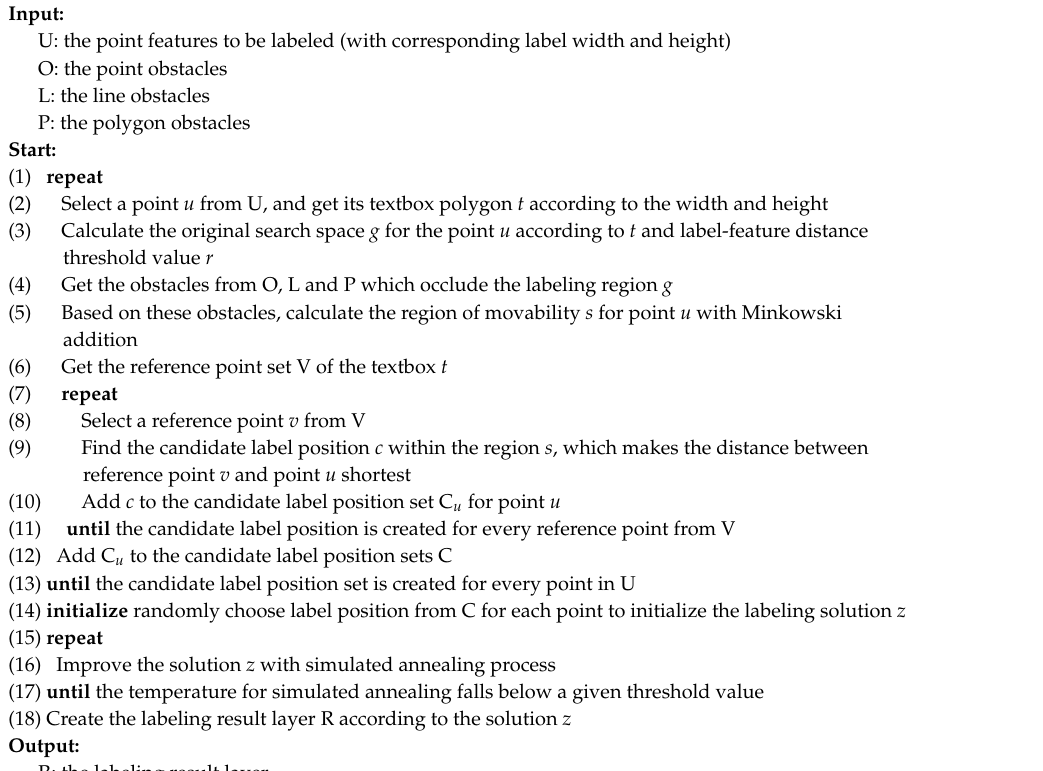
Algorithm 1 Region of movability based point-feature labeling